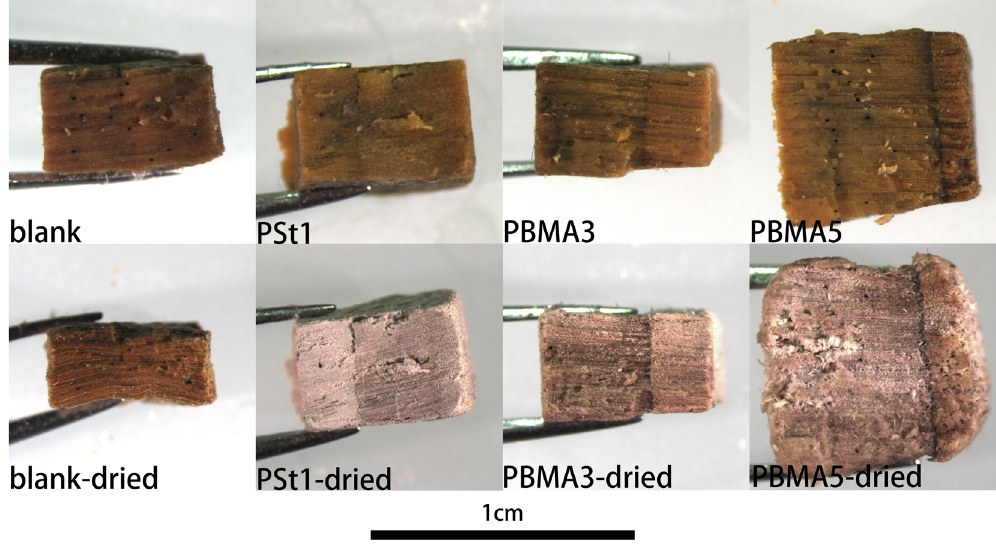
Figure 9. Appearance of the samples before and after the treatment and